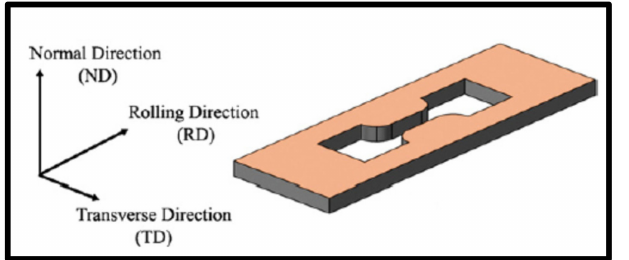
Figure 2. Orientation of the tension specimens prepared after each ARB